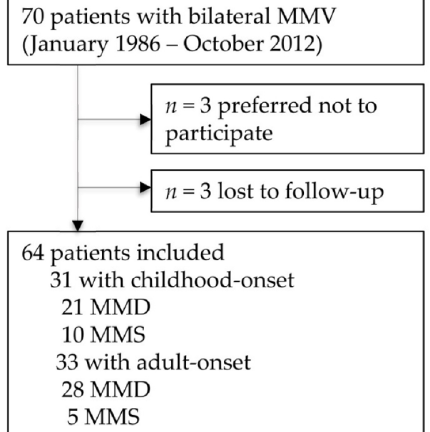
Figure 1. Flowchart patient selection. MMD = moyamoya disease; MMS = moyamoya syndrome; MMV = moyamoya vasculopathy.